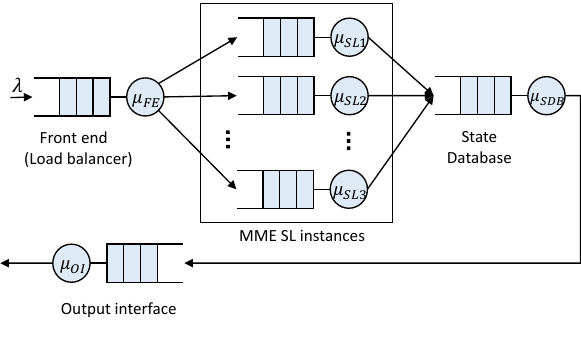
Figure 9. Queue model of the